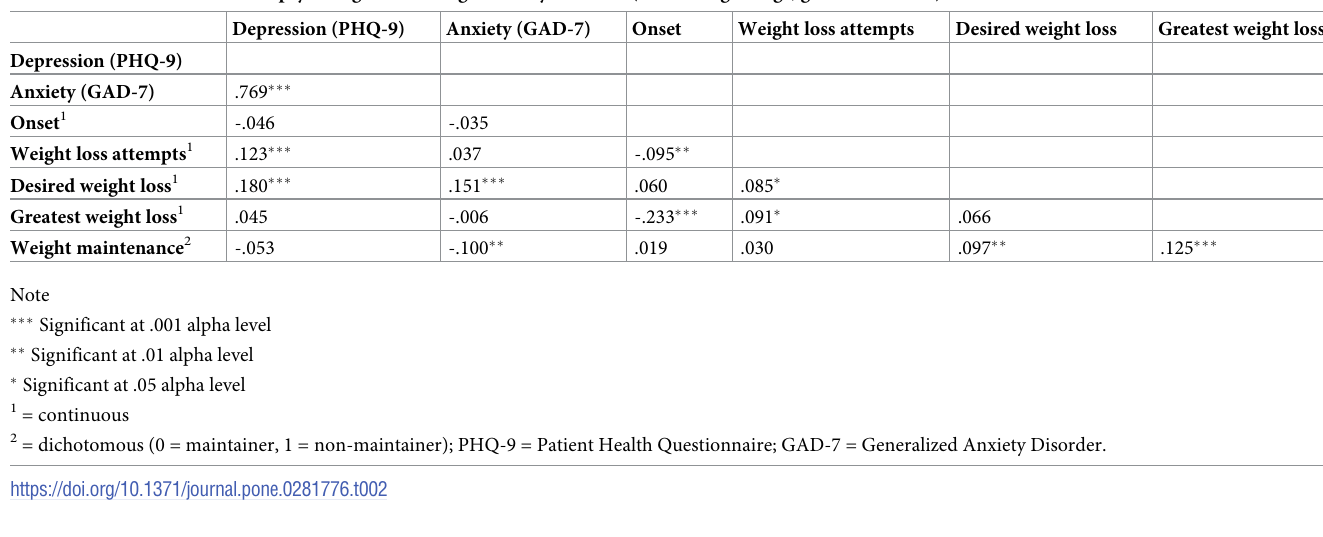
Table 2. Partial correlations for psychological and weight history variables (controlling for age, gender and